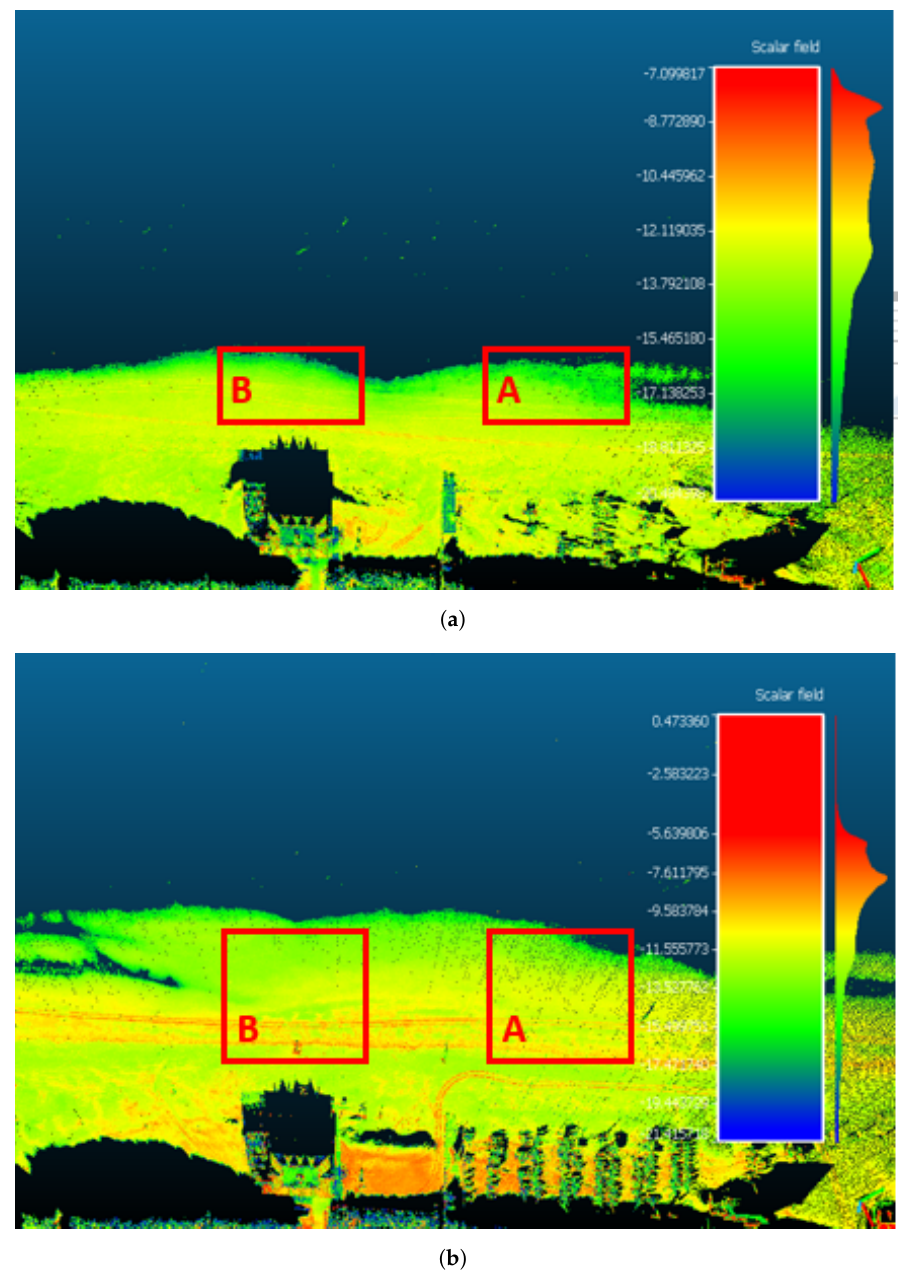
Figure 2. View of the backscatter intensity (dB) of the two fieldwork areas. ( a ): High-tide conditions (14 July 2019, 8:02 a.m.). ( b ): Low-tide conditions (12 October 2019, 8:02